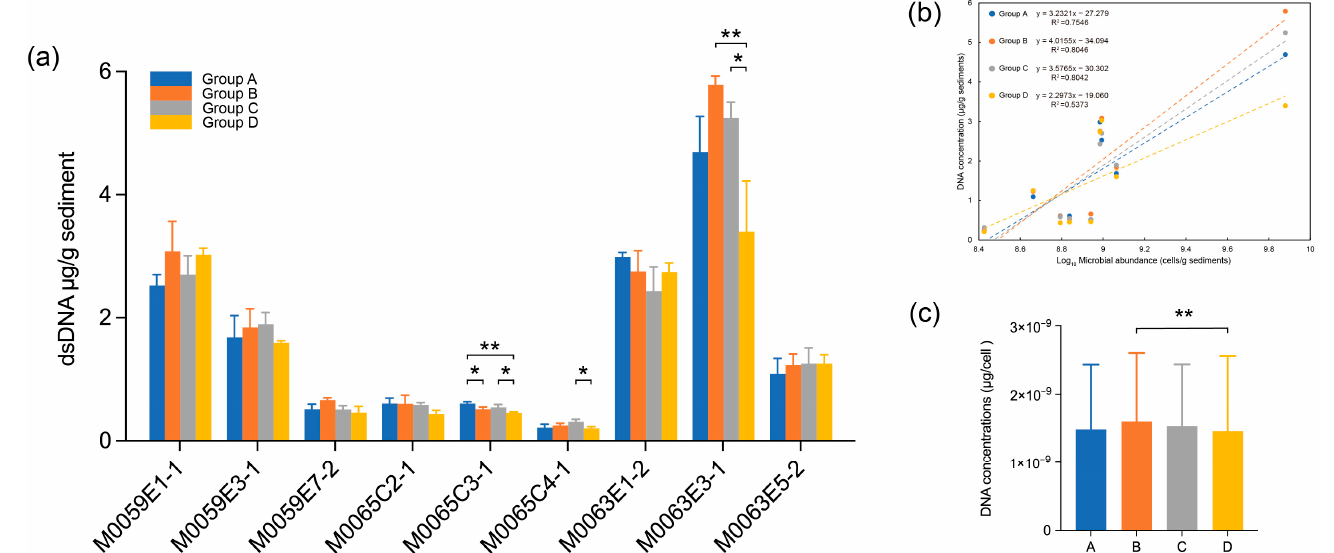
Figure 3. ( a ) For the same sediment sample, the differences in DNA concentrations extracted by four grinding bead combinations. ( b ) Relationship between DNA concentration and microbial abun- dance (log 10 transformed), p < 0.05 by linear regression. ( c ) The differences in normalized DNA con- centrations extracted by four grinding bead combinations. The line in data plots indicate median value with standard deviation (SD). Asterisks denote significance, “*” represent p < 0.05, “**” repre- sent p < 0.01, respectively.